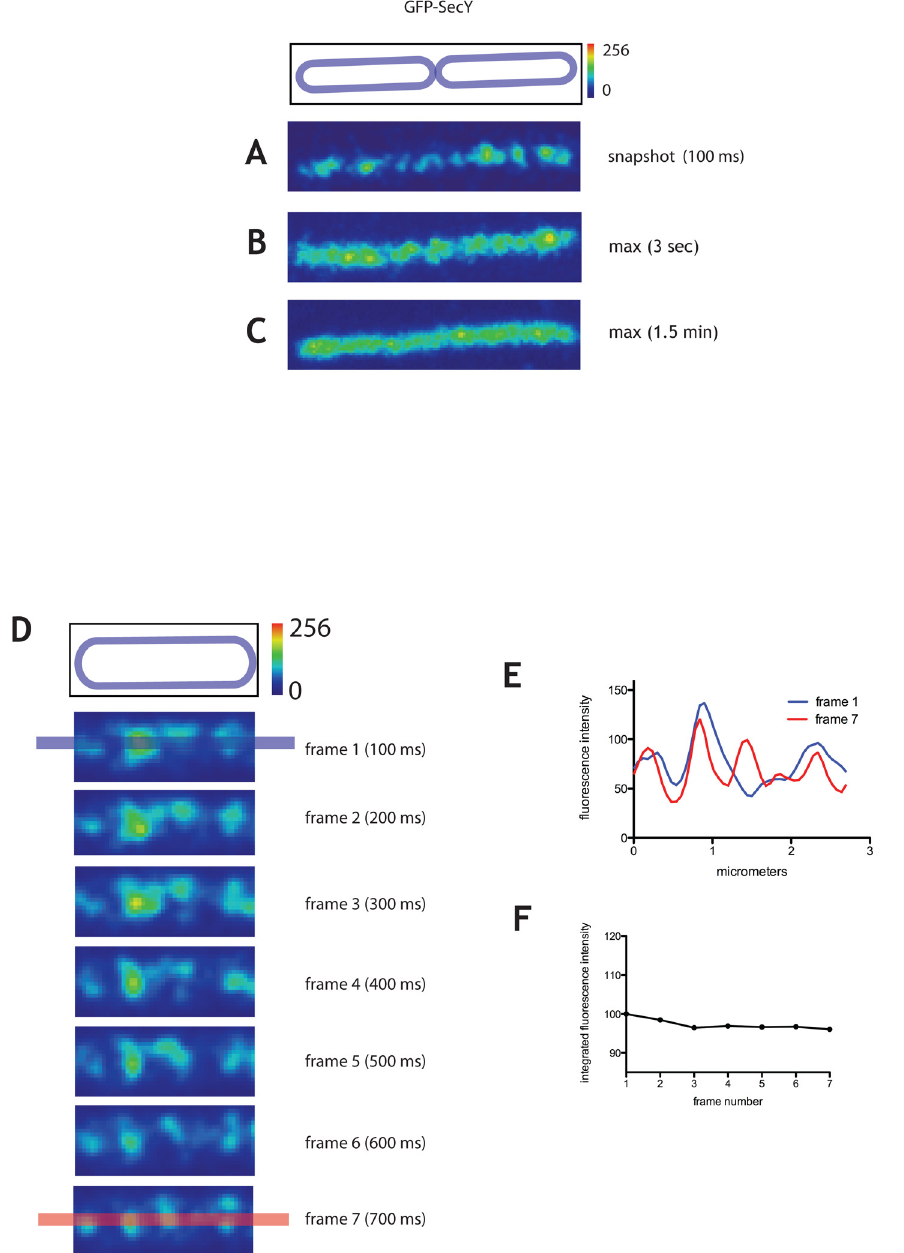
Fig 2. Dynamics of GFP-SecY on the membrane. Distribution of GFP-SecY on the membrane of exponentially growing B . subtilis cells. Strain amyE::pGY1 ( amyE pxyl-gfp-secY spc ) was grown in LB in the presence of 0.05% xylose. Time series were taken over 1 min in streaming mode using 100 ms integration time. A typical cell is displayed with ‘ physics ’ LUT from FIJI (see Materials and Methods). A. 100 ms exposure TIRF image, B. and C. maximum projection of a 3 s ( B ) time window and (C) 1.5 min time window. The cell outlines are shown above the panels (see Materials and Methods). D. Cell outline and successive frames from a time-lapse TIRF acquisition taken in streaming mode. Intensity scale for fluorescence, 1 μ m. E. Fluorescence intensity profiles along the line drawn over the long axis of the cell for frames 1 and 7, as shown in blue and red respectively, panel G. F. Integrated fluorescence intensities for the entire surface of the cell for the frames shown in panel